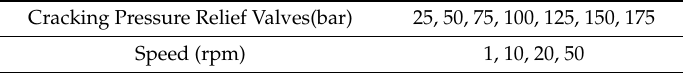
Table 1. Operating conditions tested in the test rig.